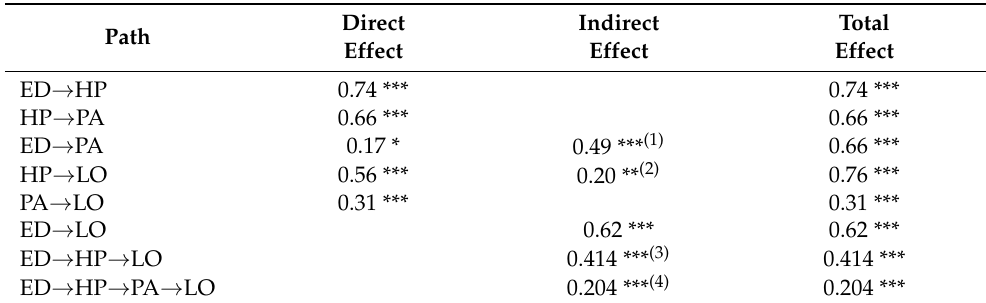
Table 5. The total effects among the four constructs and the mediating effect of healing perception and place